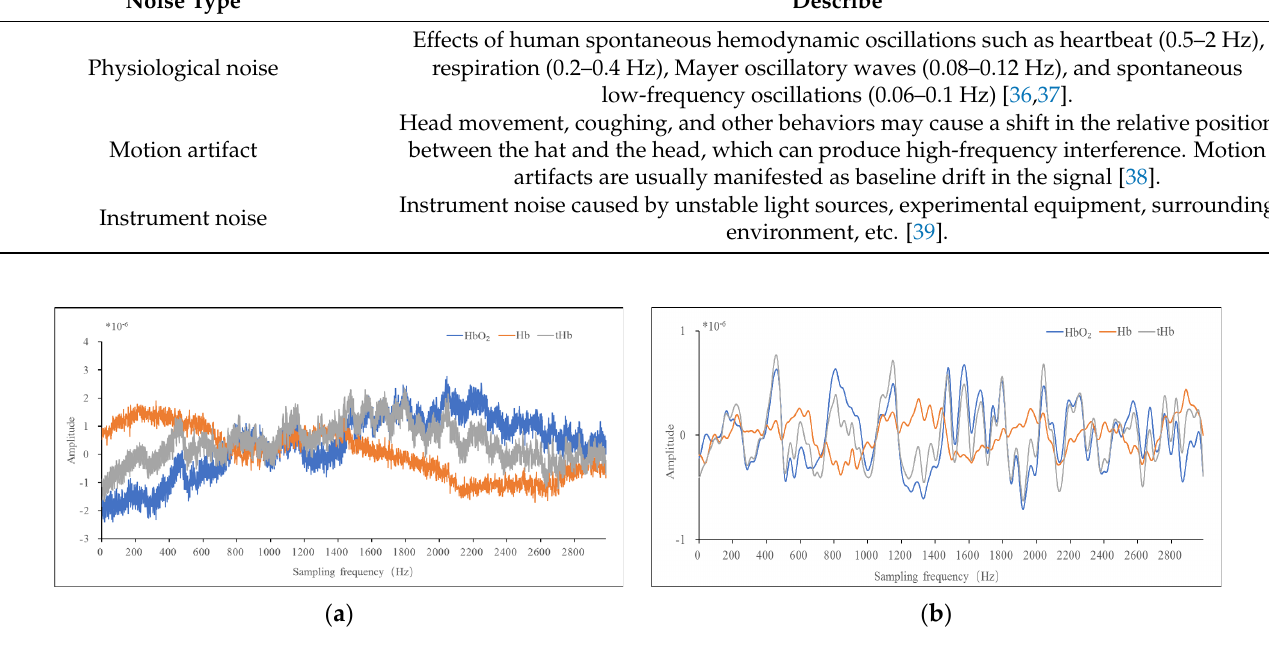
Figure 6. Schematic diagram of fNIRS data before and after denoising. ( a ) fNIRS data before denoising; ( b ) fNIRS data after denoising.